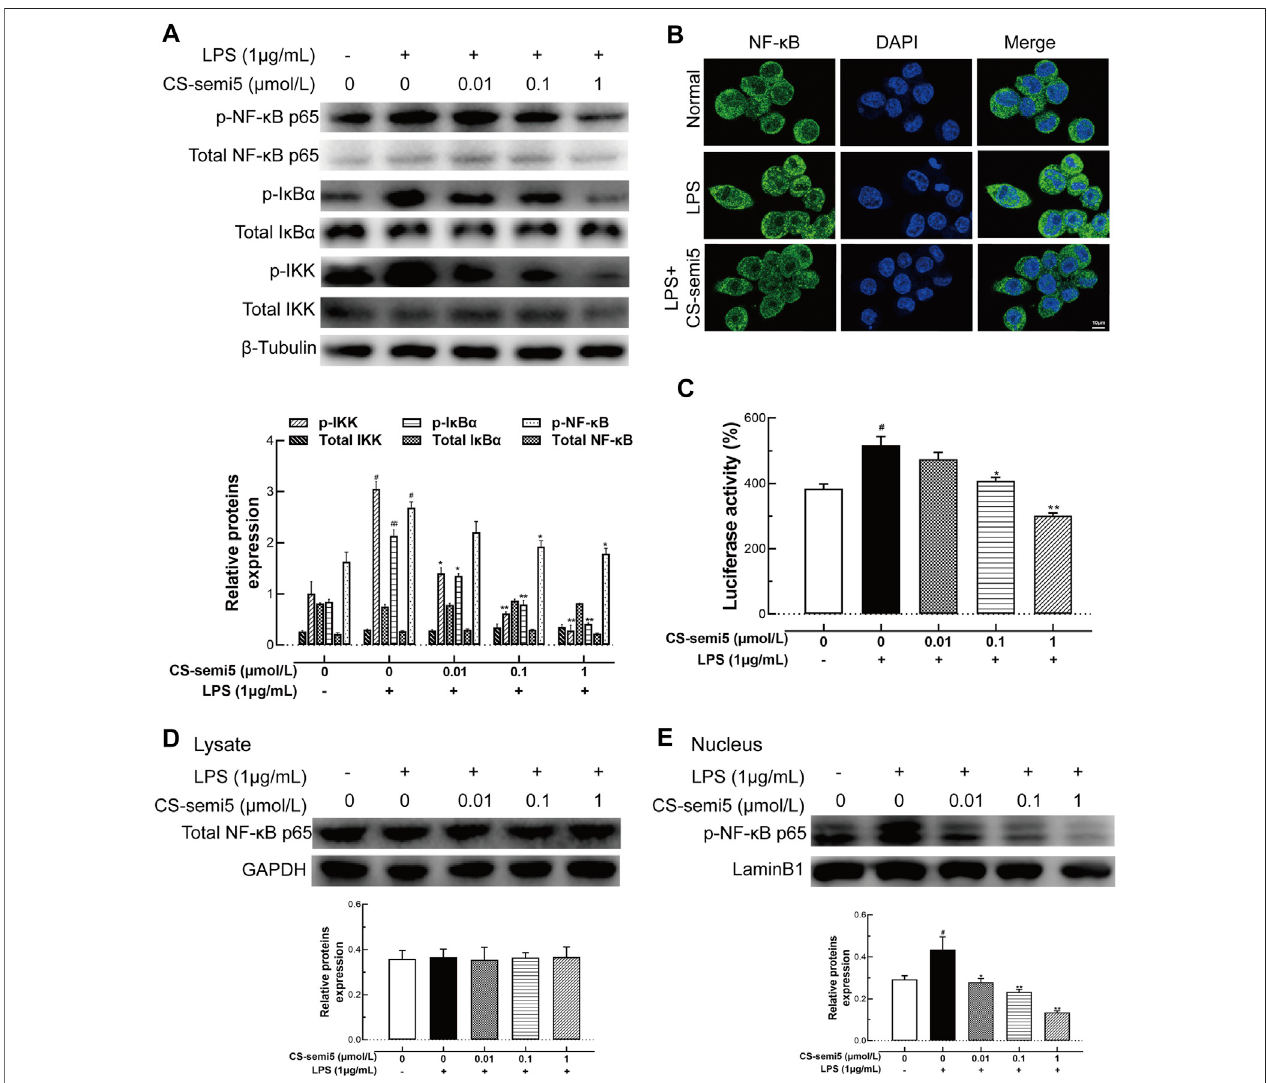
FIGURE7| CS-semi5inhibitsactivationoftheNF- κ Bpathway. (A) RAW264.7cellsweretreatedwithCS-semi5(0.01,0.1or1 μ mol/L)for24 h.IKK,I κ B α ,andNF- κ Bphosphorylationwasexaminedbywesternblot. (B) LPS-inducednucleartranslocationofNF- κ Bp65wasassessedbyconfocallaser fl uorescencemicroscopy.Cells were immuno-stained with an NF- κ B p65 antibody (FITC, green), and nuclei were stained with DAPI in blue. Bar indicates 10 μ m. (C) 293T cells were transfected with NF- κ B luciferase plasmid, then treated with CS-semi5 for 24 h. Luciferase activity was assayed. (D,E) RAW264.7 cells were stimulated with LPS and treated with CS-semi5(0.01,0.1or1 μ mol/L)for24 h.NF- κ Bp65inthecelllysissolutionandinthenucleuswererespectivelydetermined bywesternblot. n (cid:1) 3. # p < 0.05and ## p < 0.01 compared with Control Group; * p < 0.05 and ** p < 0.01 compared with LPS stimulation Group.